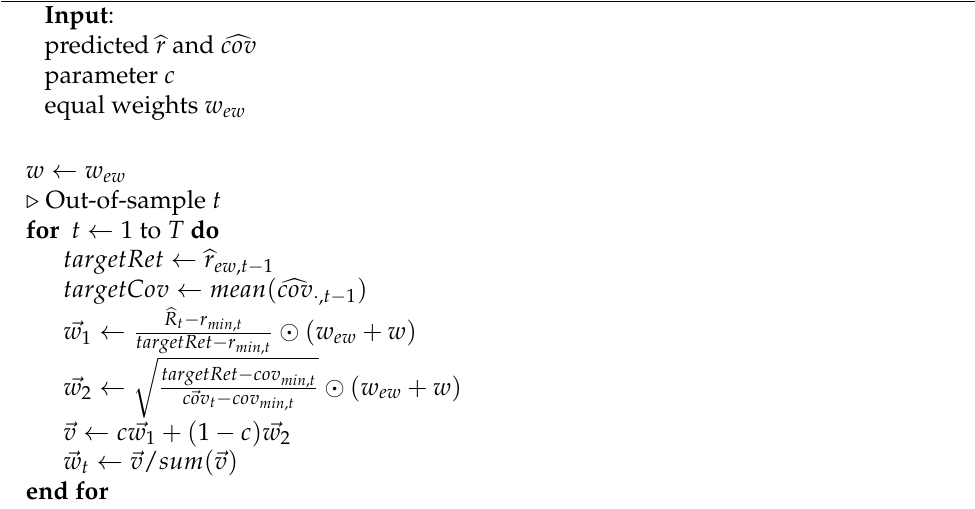
Algorithm 2 Weight Update for Each Successive